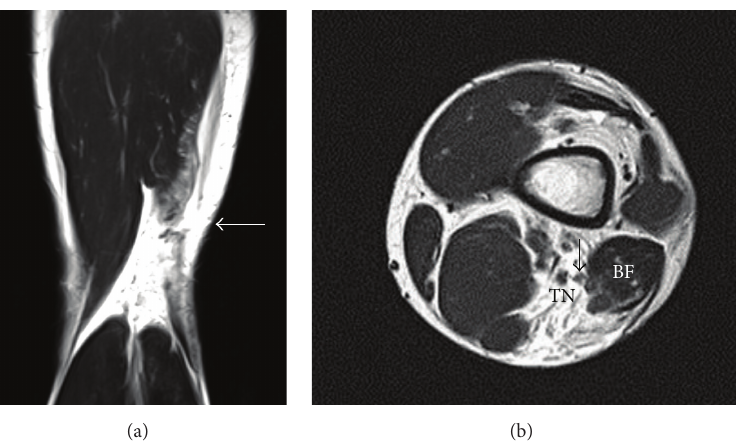
Figure 1: T2-weighted coronal magnetic resonance image of left thigh. Complete rupture of distal biceps femoris tendon at the musculotendinousjunction(a).T2-weightedaxialmagneticresonanceimageofleftthighshowscloserelationshipbetweencommonperoneal nerve (arrow) and biceps femoris muscle (b). BF, biceps femoris muscle; TN, tibial nerve.